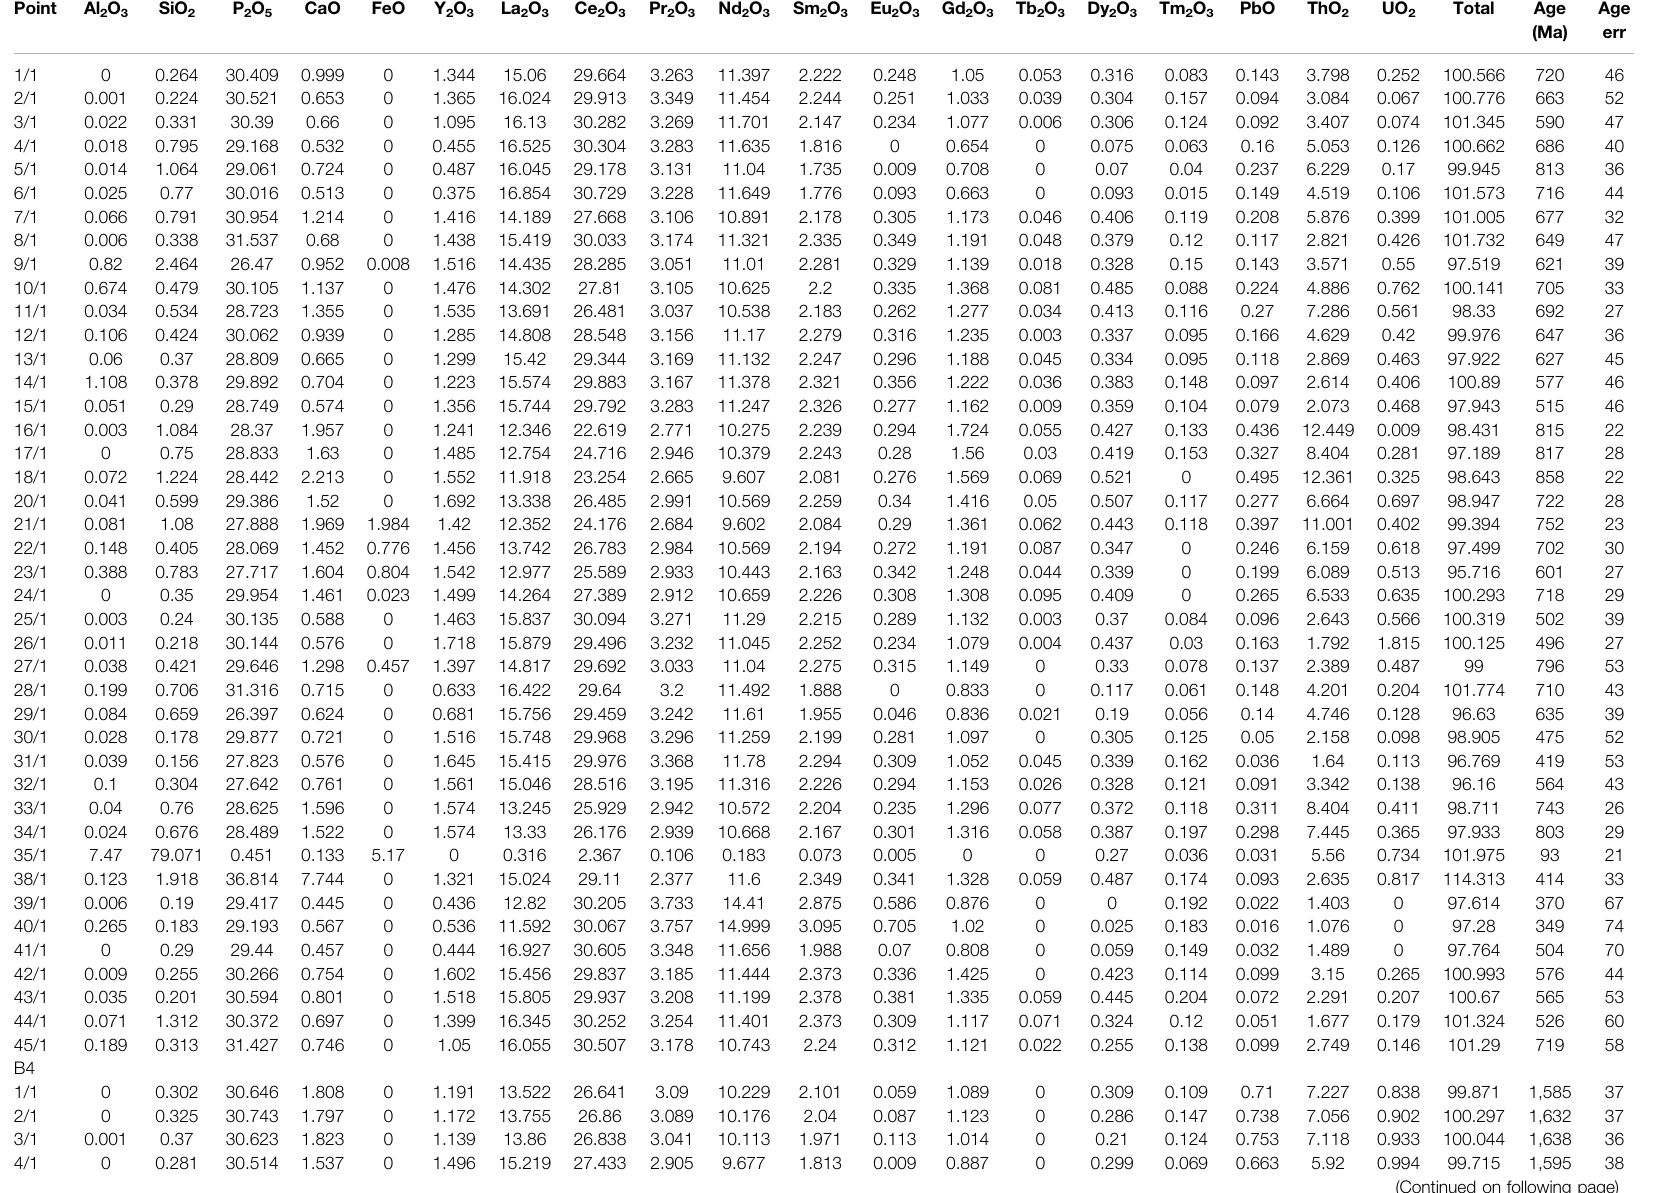
TABLE 4 | EPMA analytical result of monazite for the samples CG-1 (26,014 ′ 12 ’’ /,74,013 ′ 25 ″ ), B-4 (26,013 ′ 44 ’’ /,74,013 ′ 12 ″ ), B-5 (26,013 ′ 27 ’’ /,74,013 ′ 12 ″ ), and R-4 (26,012 ′ 56 ’’ /,74,018 ′ 30 ″ ). CG1